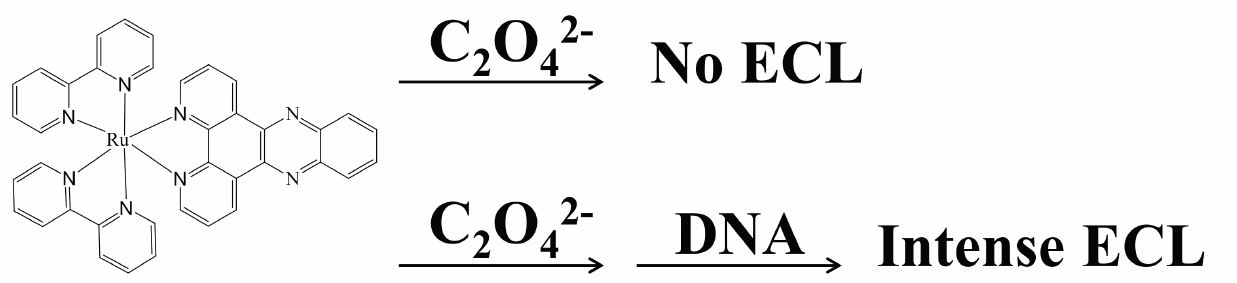
Figure 22. Scheme of ECL switch, based on [Ru(bpy) permission from ref. [88], copyright (2009) American Chemical Society.